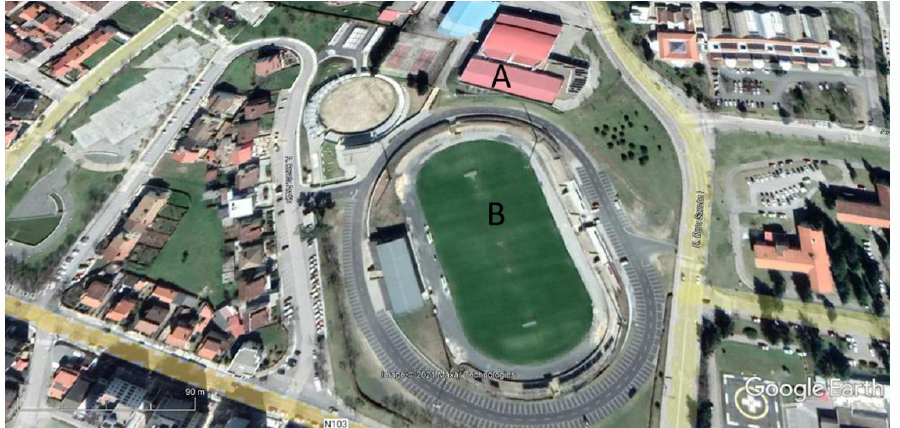
Figure 2. Plan of the Bragança swimming pool complex ( A ) and football stadium ( B ) (source: Google Earth).